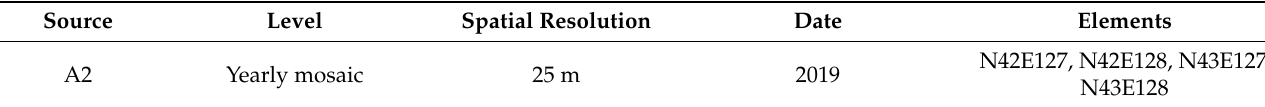
Table 3. The adopted images from A2, S1, S2, and A1